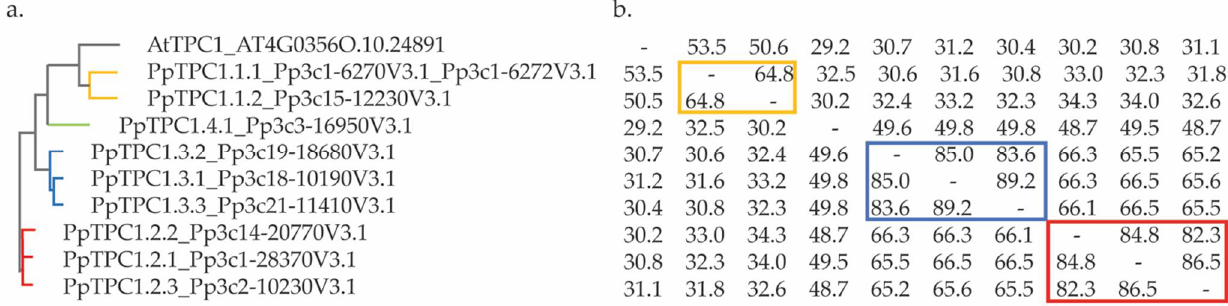
Figure 2. Ancestry and homology analysis of TPC1-like sequences from P. patens . ( a ). Cladogram of the TPC1 sequences in A. thaliana and P. patens ; ( b ) Percent identity matrix corresponding to the alignment of the TPC1 channel sequences of A. thaliana and P. patens . The colors indicate cluster 1 (yellow), cluster 2 (red), cluster 3 (blue), and cluster 4 (green).